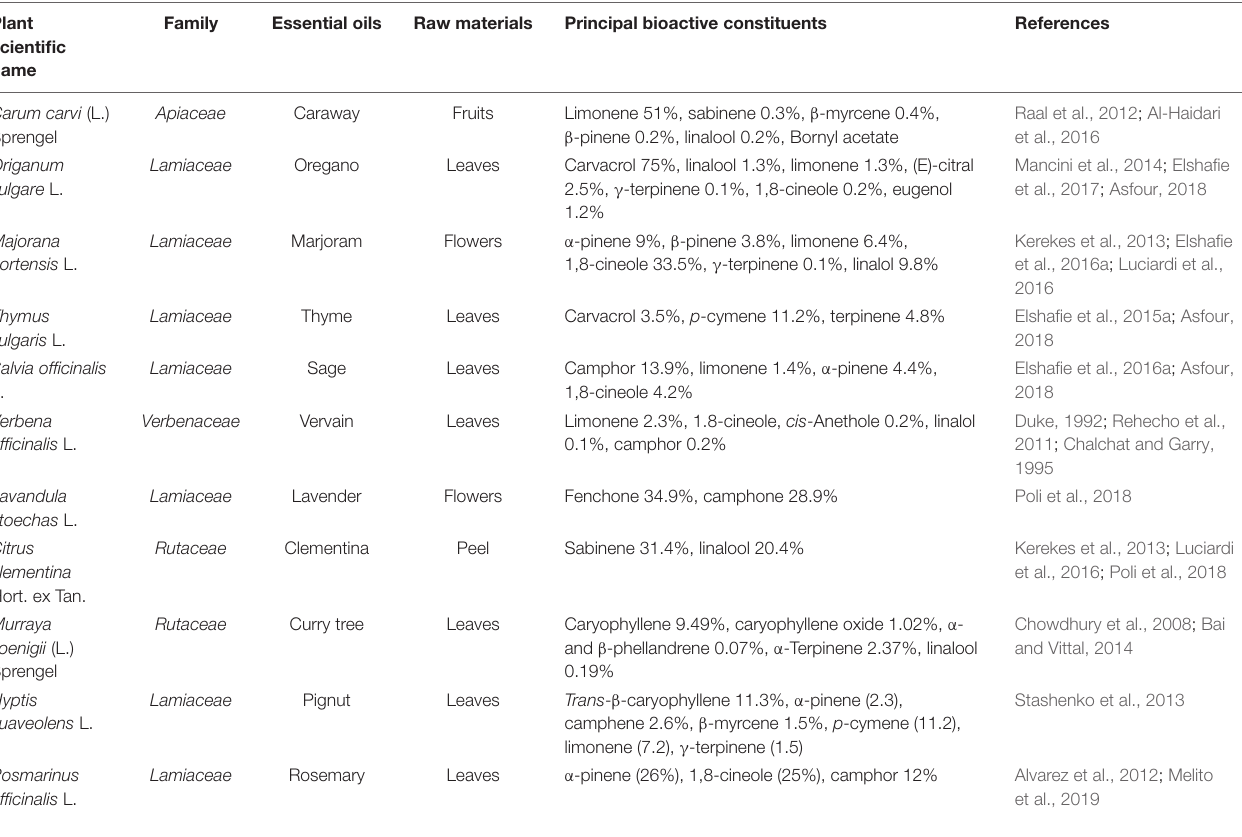
TABLE 1 | List of common plant EOs and their single constituents that display anti-QS